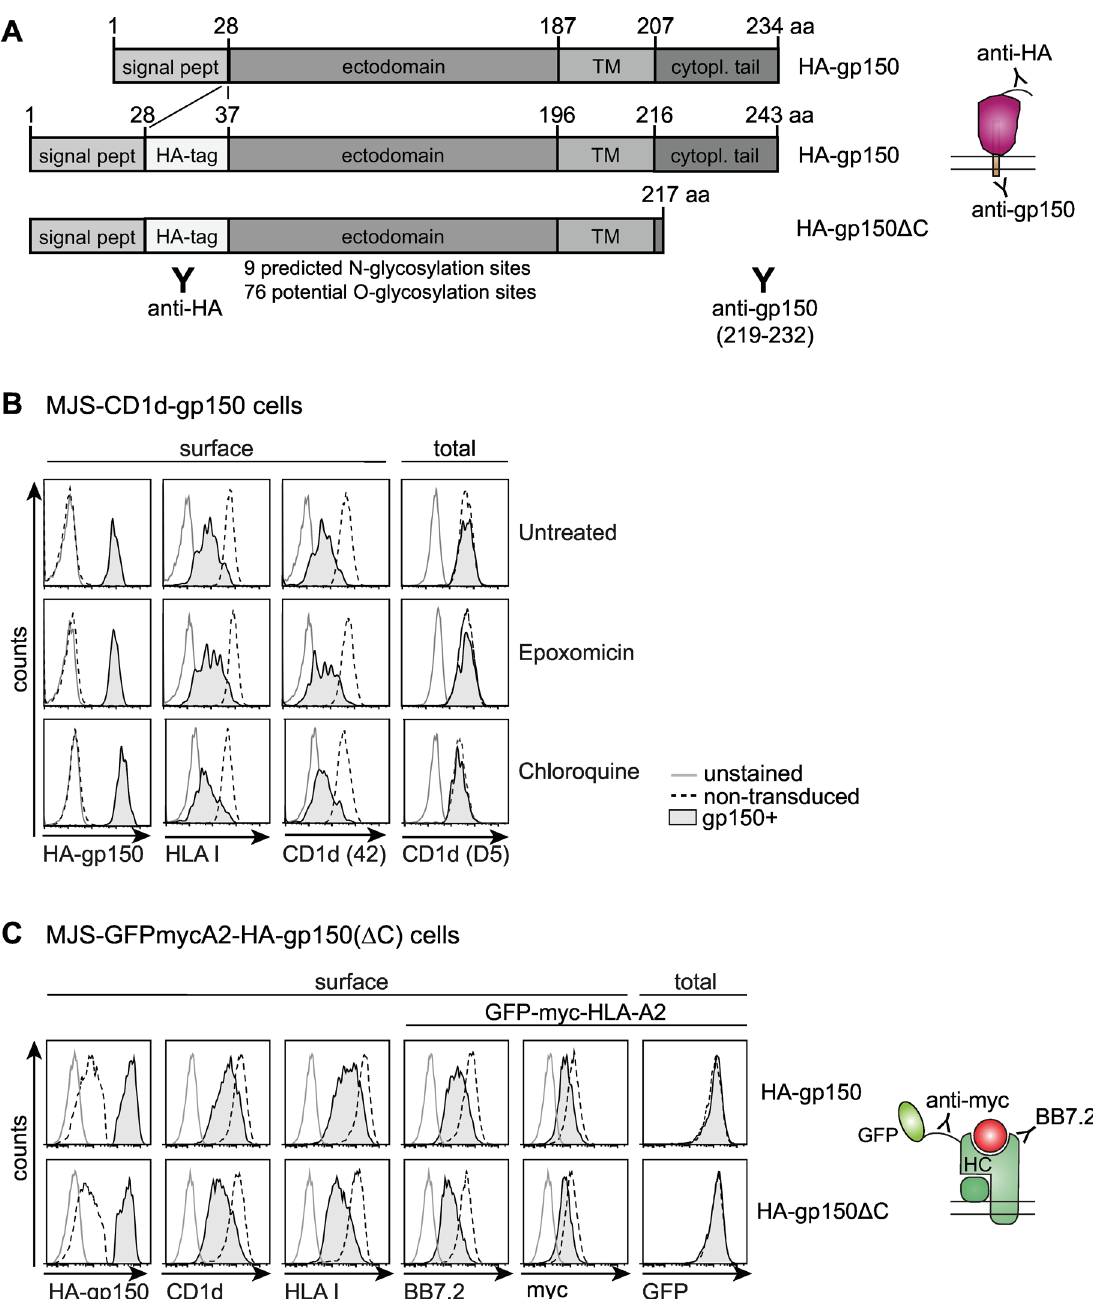
Fig 4. Immune evasion by EBV gp150 does not depend on degradation of Ag-presenting molecules nor on gp150 ’ s cytoplasmic tail. A) Schematic overview of the gp150 constructs and Abs used. Signal peptide, transmembrane domain, and cytoplasmic tail are abbreviated as signal pept, TM, and cytopl tail, respectively. B) Three days after lentiviral transduction, MJS-CD1d-gp150 cells were cultured overnight in the presence of an inhibitor of proteasomes (15nM epoxomicin) or of endolysosomal proteolysis (25 μ M chloroquine). Subsequently, flow cytometry was used to determine surface levels of HA-tagged gp150 (HA-gp150; detected with anti-HA Ab), HLA I, and mature CD1d (Ab #42) complexes on non-permeabilized cells and intracellular staining was performed to detect immature CD1d (Ab D5) molecules in permeabilized cells. C) MJS-GFPmycA2 cells were transduced with a lentivirus encoding HA- gp150 (upper) or HA-gp150 Δ C (lower). Cell surface levels of CD1d, HLA I, and HLA-A2 (BB7.2 and anti-myc tag) and total HLA-A2 (GFP) levels were compared for gp150 - and gp150 + cells.